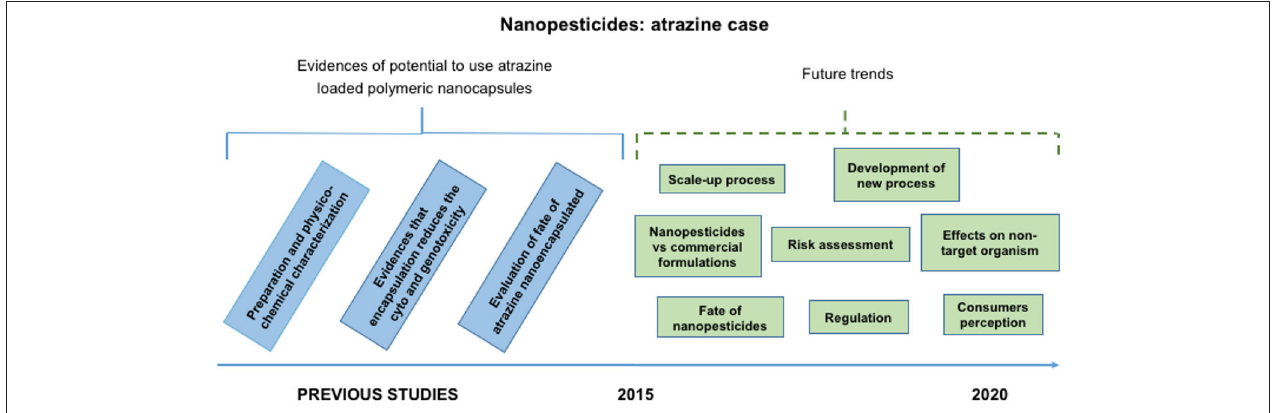
FIGURE 2 | Timescale for developments in atrazine